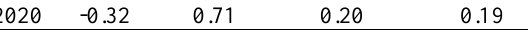
Table 4 Summary statistics for NDVI for Bhubaneswar (2001-